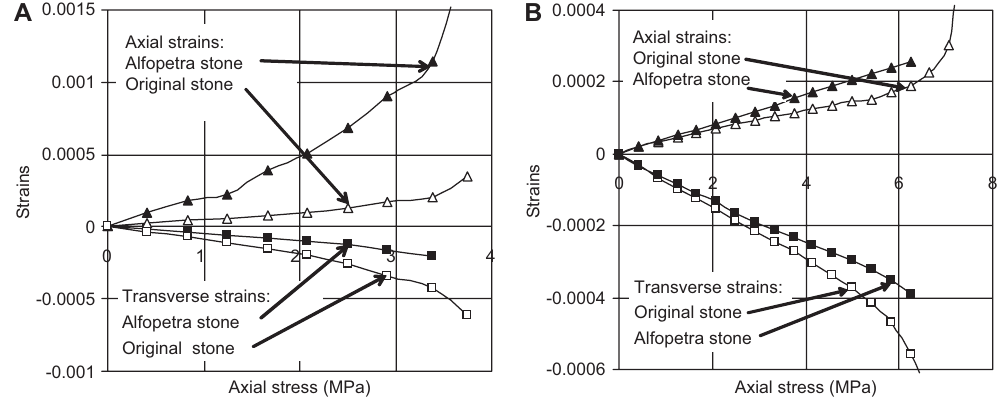
Figure 20 The axial (triangular symbols) and the transverse (square symbols) strains for the original (empty symbols) and the new stone (fi lled symbols) in the vicinity of the interface for θ = 15 ° (A) and θ = 60 °